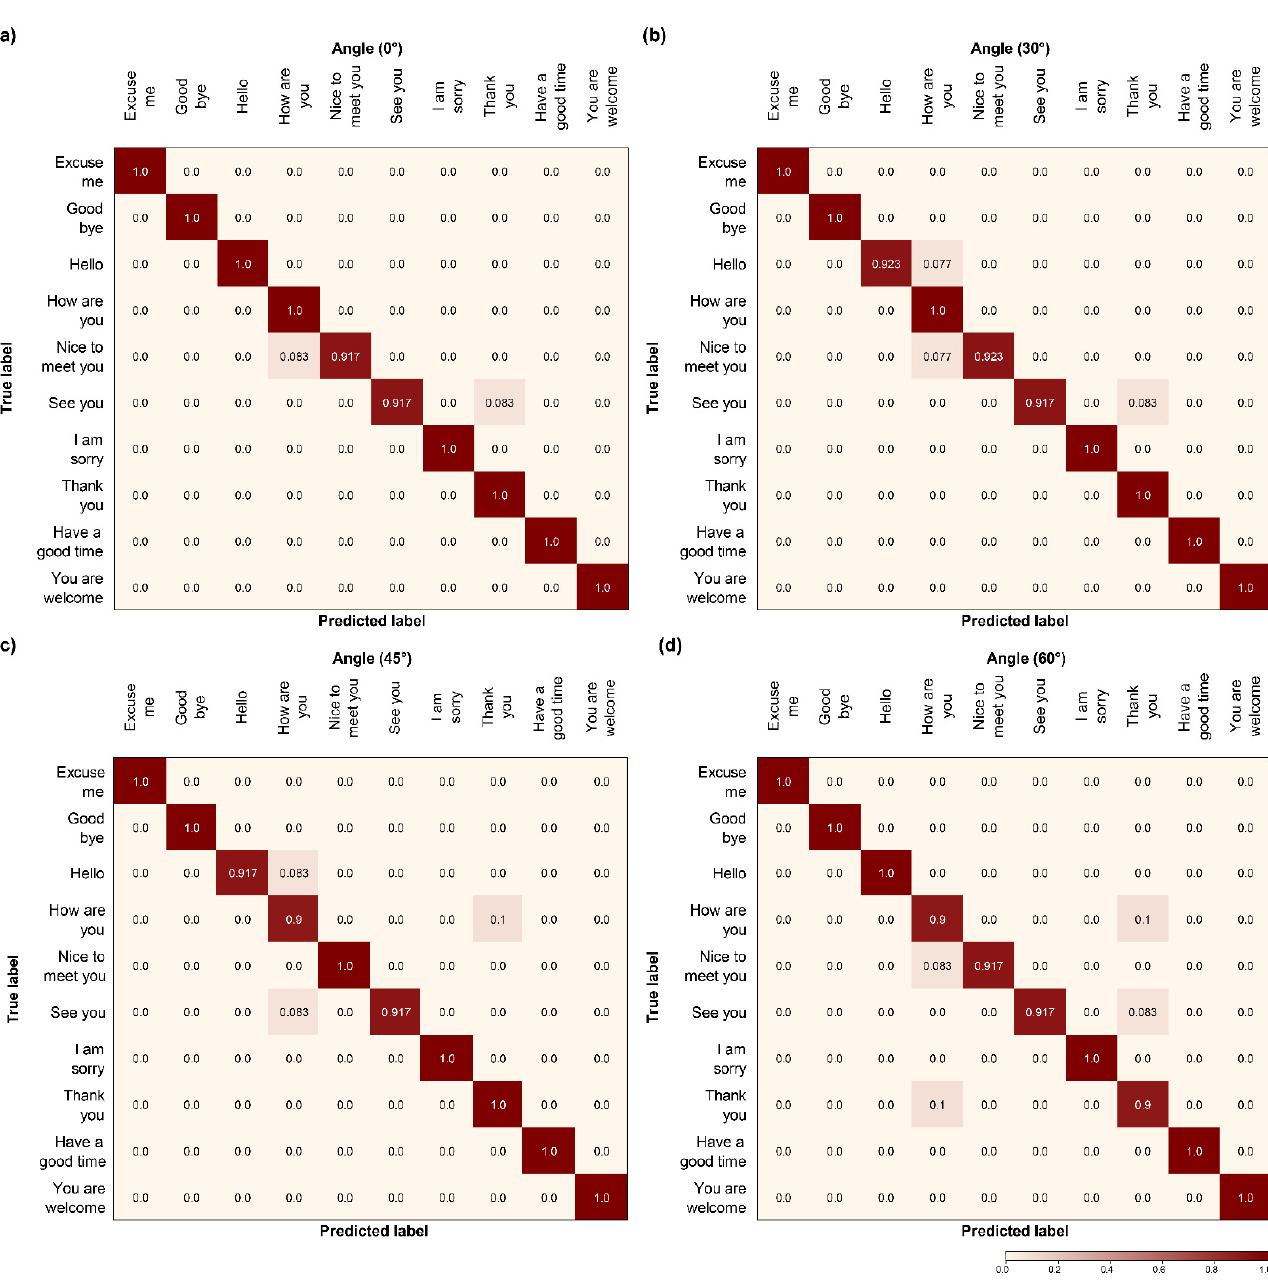
Figure 14. Comparison of confusion matrix models: ( a – d ) the proposed model.